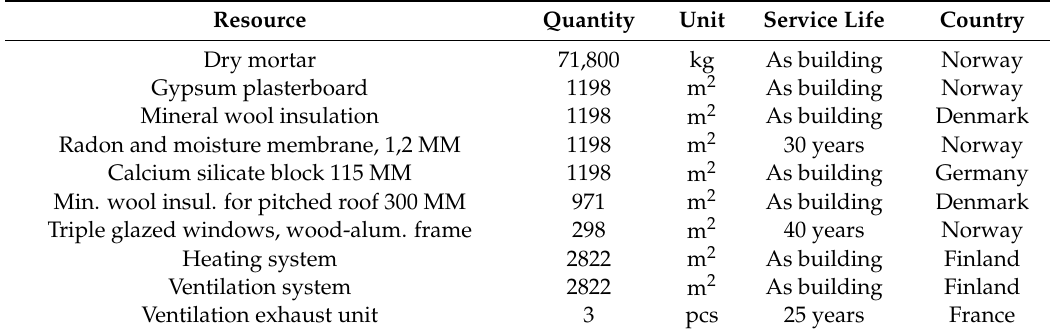
Table 4. BEnS dataset.